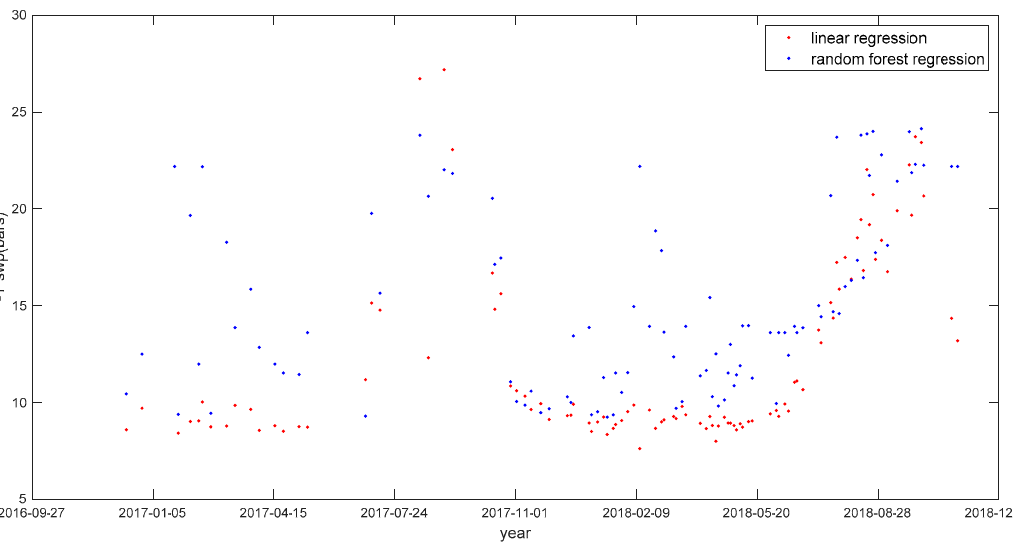
Figure 10. Stem water potential time series plot based on random forest regression and linear regression.